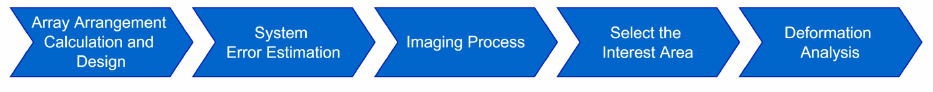
Figure 1. The TD-MIMO GB-SAR system design and bridge vibration monitoring